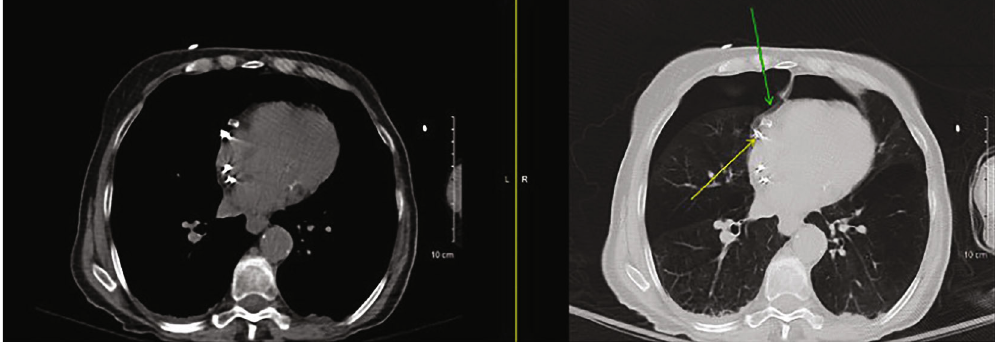
Figure 2: Yellow arrow showing the RA lead penetrating the atrial wall and green arrow showing the